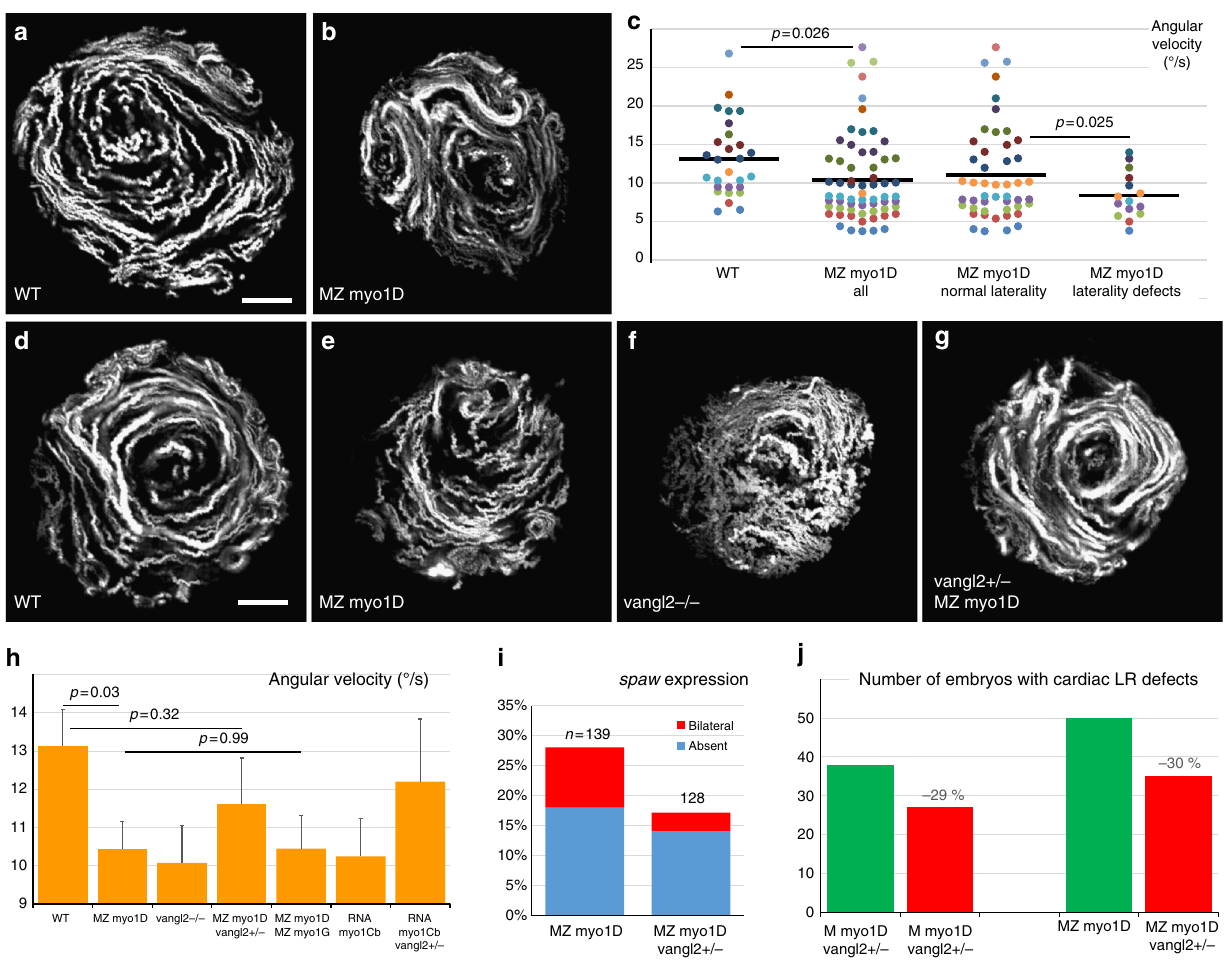
Fig. 4 myo1D is required for the establishment of zebra fi sh left – right organizer fl ow. a – c KV fl ow is altered in MZ myo1D mutants. Temporal projections of the trajectories of fl uorescent microspheres in WT ( a , n = 28) and MZ myo1D mutants ( b , n = 63). c MZ myo1D embryos display lower mean angular KV fl ow velocities than WT. MZ myo1D mutants with defective cardiac jogging show lower velocities than their sibling with normal laterality. d – g MZ myo1D ( e ) and vangl2 ( f , n = 36) mutants present an altered LRO fl ow compared to WT ( d ) but fl ow pattern is restored in MZ myo1D ; vangl2 + / − ( g , n = 25). h MZ myo1D mutants display a reduced KV fl ow velocity compared to WT, as do vangl2 − / − embryos ( p = 0.03). Flow in MZ myo1D ; vangl2 + / − is however similar to WT. Flow velocity in MZ myo1D ; MZ myo1G double mutants is reduced compared to WT ( n = 29, p = 0.04) but similar to MZ myo1D single mutants. Flow velocity in WT embryos injected with myo1Cb RNA is reduced compared to WT controls ( n = 37, p = 0.04). Removal of one copy of vangl2 makes fl ow velocity again similar to WT ( n = 19, p = 0.62). i , j The removal of one copy of vangl2 reduces defects in asymmetric spaw expression ( i ) and cardiac morphogenesis ( j ) in MZ myo1D (see Methods). a , b , d – g are dorsal views of eight-somites stage KVs, anterior up. Display items and quanti fi cations in a – h are derived from the same dataset. Horizontal bars in c represent mean values. Error bars in h indicate SEM. Scale bars: 20 µ m in a , b